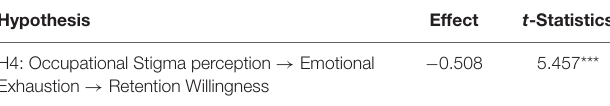
TABLE 6 | Discriminant validity.